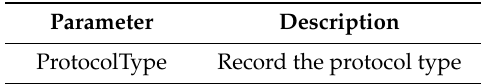
Table 3. Parameter settings of the TCP-SCTP switch process.